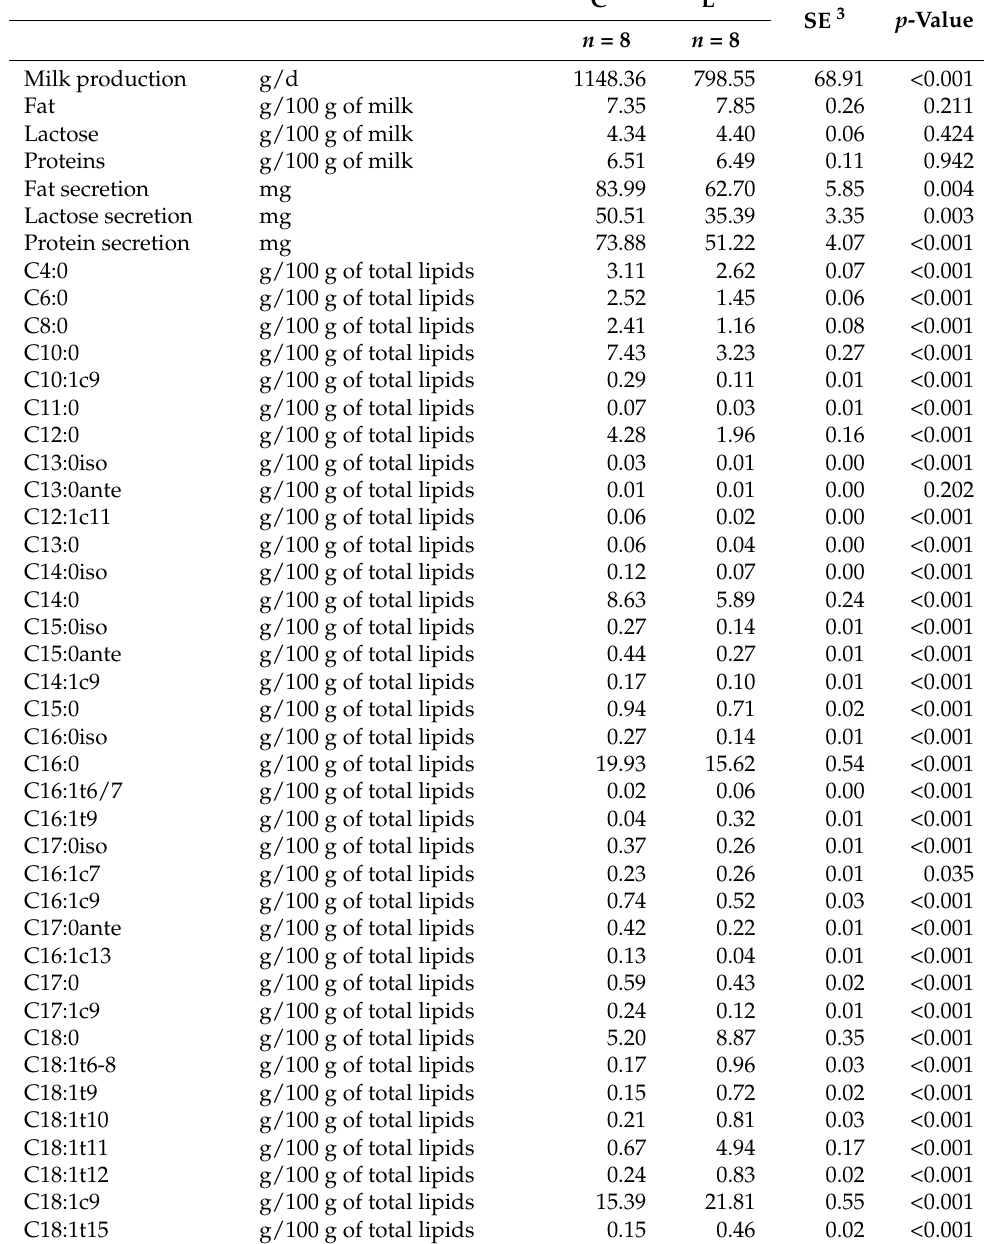
Table 1. Effect of linseed supplementation on milk production and composition and fatty acid